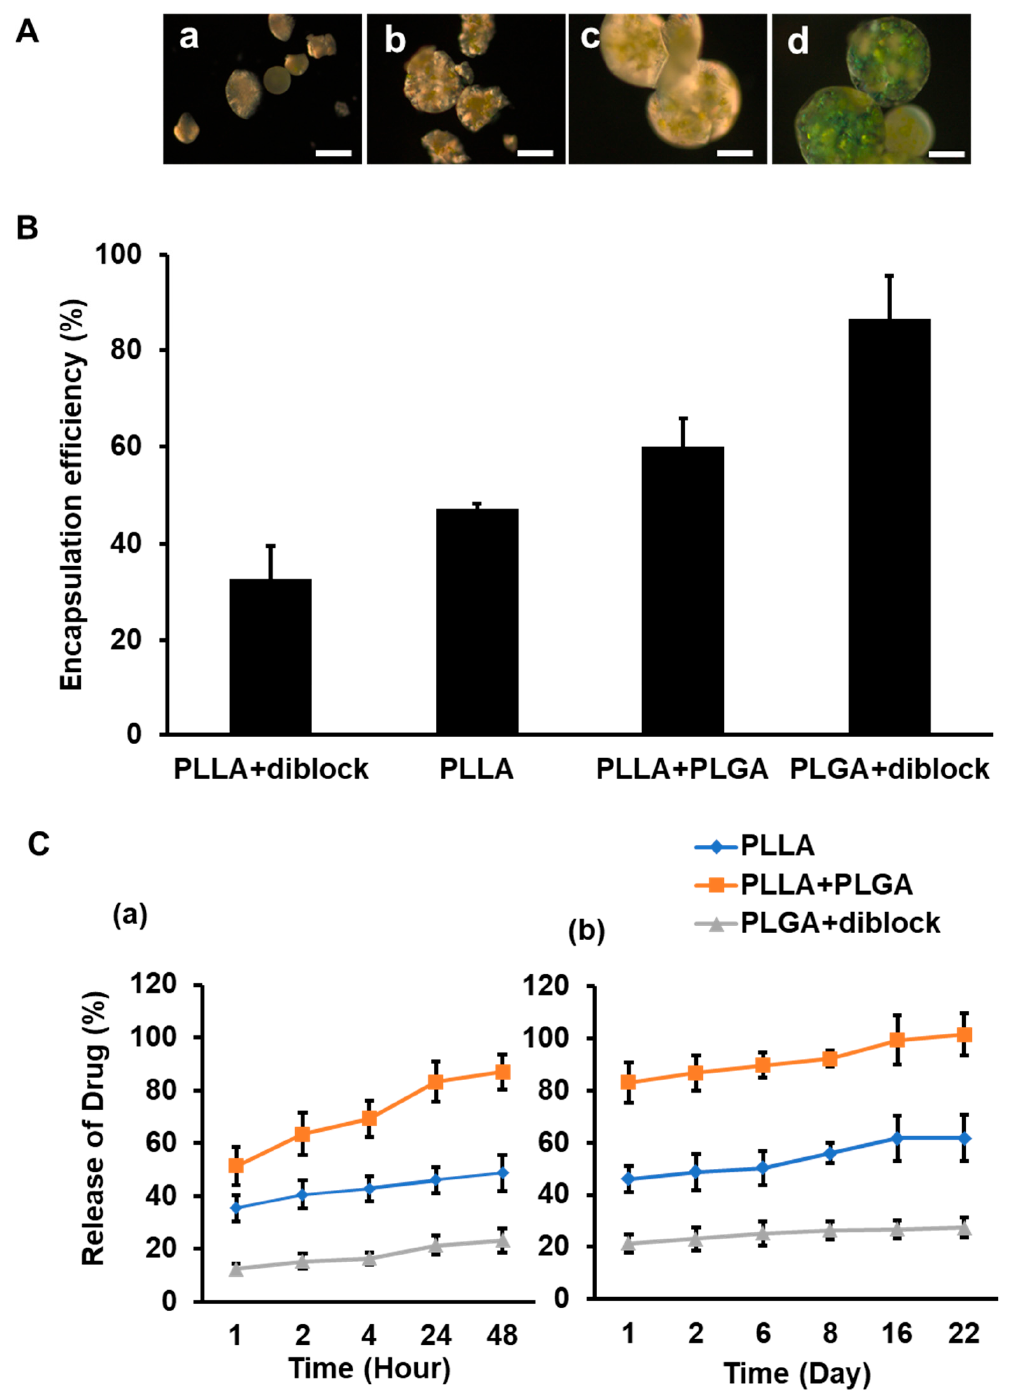
Figure 2. Encapsulation efficiency and in vitro drug release profile from the microspheres. ( A ) Po- larized light microscopy images of MTX encapsulated in PLLA+ MePEG- diblock ( a ), PLLA ( b ), PLLA +PLGA ( c ), and PLGA + MePEG- diblock polymer microspheres ( d ), scale bar = 200 μ m. ( B ) Quantification of the encapsulation efficiency of four separate batches of each formulation revealed that PLLA + MePEG- diblock had the least and PLGA + diblock had the highest encapsulation effi- ciency. ( C ) Comparison of three different formulations of the polymer showed that PLLA + PLGA microspheres had the highest initial burst release at the first 48 h ( a ), and almost 100% of the encap- sulated MTX was released from them after 16 days ( b ). PLGA+ MePEG- diblock microspheres had the lowest initial burst release both at the first 48 h ( a ) and after 22 days ( b ).